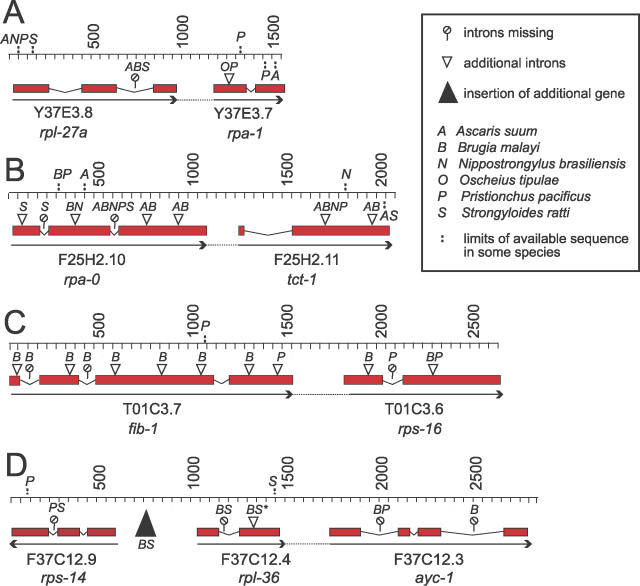
Conservation of Operonic Structures in Distantly Related NematodesThe genomic structure of four conserved nematode operons is shown. Exons are depicted with rectangles, and introns with thin lines. The gene structures and scales (in base pairs) are from the C. elegans genomic sequence; the structure of the operons and the exon/intron boundaries are conserved in C. briggsae. Arrows indicate direction of transcription, and the dotted lines linking arrows indicate operonic structures. The position of novel introns in other nematodes is indicated by open arrowheads. Where only a fragment of the operon has been isolated, the extents of the isolated fragment are indicated on the base scale by vertical dashed lines and the taxa thus affected by letters. The lollipop symbols indicate absence of the intron in the indicated species.(A) CEOP1032 containing rpl-27a and rpa-1: orthologues identified in A. suum, B. malayi, N. brasiliensis, O. tipulae, P. pacificus, and S. ratti.
(B) CEOP1624 containing rpa-1 and tct-1: orthologues identified in A. suum, B. malayi, P. pacificus, S. ratti, and N. brasiliensis.
(C) CEOP5428 containing fib-1 and rps-16: orthologues found in P. pacificus.
(D) CEOP3416 containing rpl-36 and F37C12.3 (an acyl carrier protein): orthologues found in B. malayi, P. pacificus, and S. ratti. The genomic structure surrounding CEOP3416 is also conserved. It contains four genes (F37C12.1, .2, .3, and .4) and spans a gene on the opposite strand (F37C12.14, in an intron of F37C12.1). rps-14 is found immediately upstream, and rps-21 one gene downstream, on the opposite strand. The filled triangle indicates the presence in B. malayi and S. ratti of an additional gene that shows similarity to C. elegans F37C12.2. Ce-F37C12.2 is found downstream of F37C12.3 in the same operonic structure CEOP3416 in C. elegans and C. briggsae. The new intron annotated with an asterisk (*) is found in B. malayi and S. ratti, but the two introns are separated by nine nucleotides of coding sequence in a protein-driven alignment: the orthology of these introns is thus debatable.